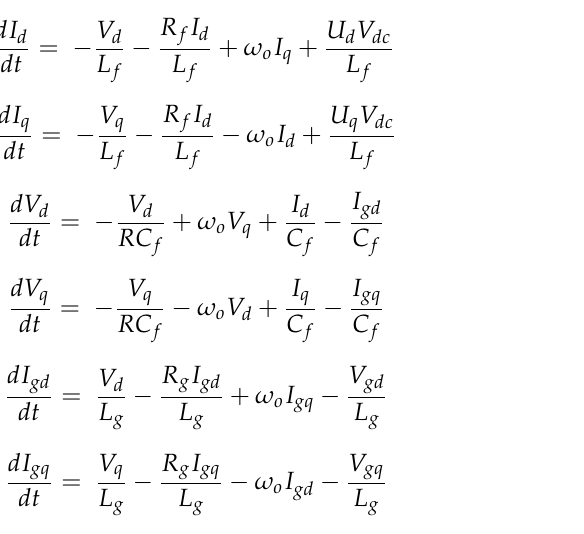
Figure 5. AC subgrid